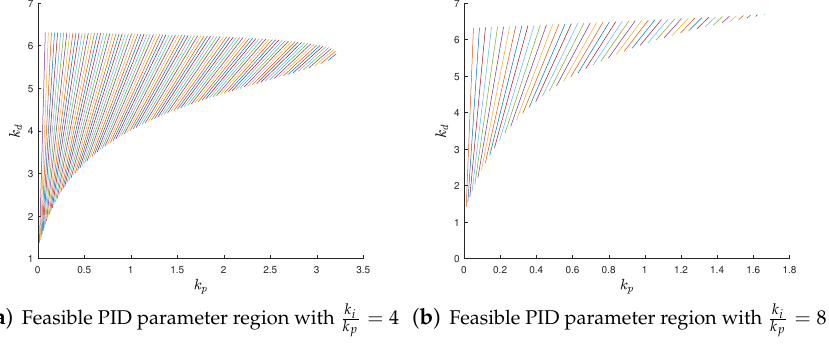
Figure 12. Feasible PID parameter region. The above two figures show the feasible PID parameter = 4 and k i = region with k i k p k p